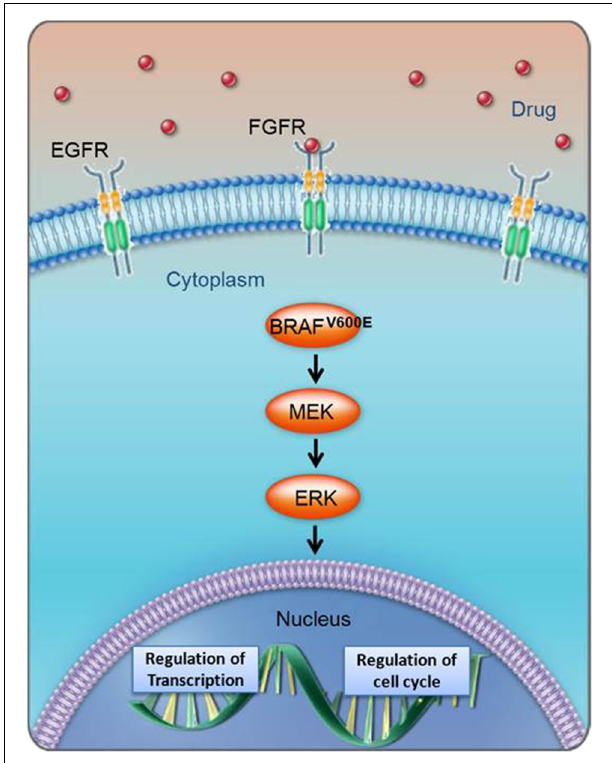
FIGURE 10 | Biological cascade of BRAF V600E activation and cell cycle implications. The BRAF V600E pathway includes multiple biomarkers whose direct or indirect response could be indicative of efficacy.